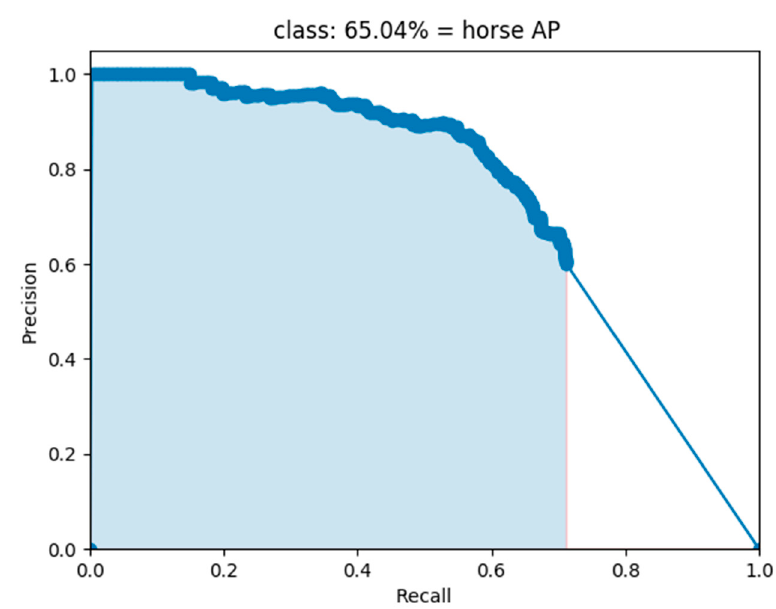
Figure 4. Mixed YOLOv3-LITE P-R curve of horse category in PASCAL VOC dataset.